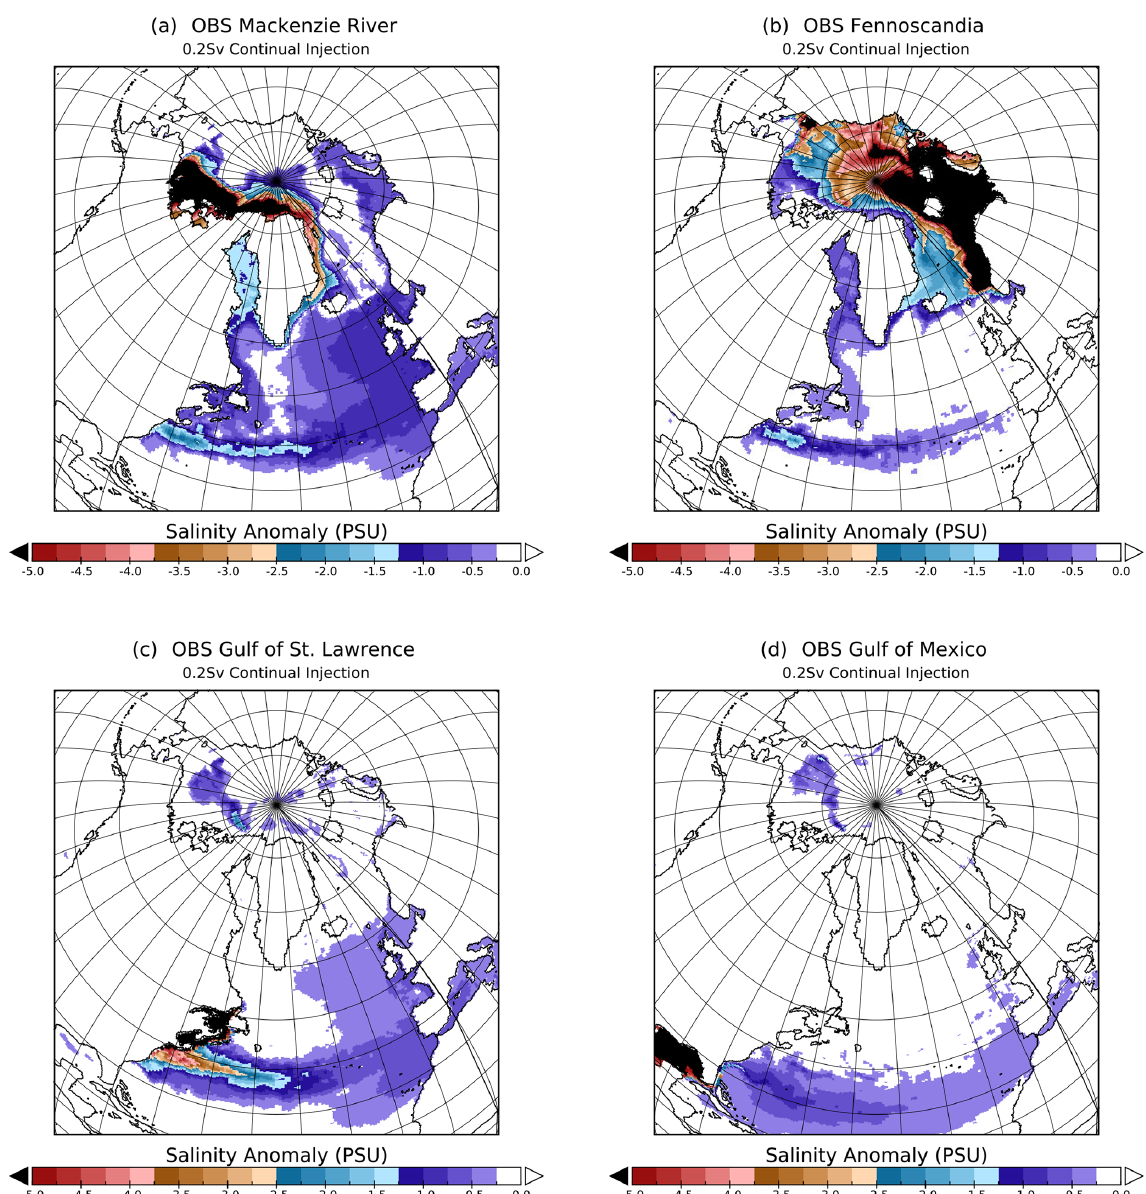
Figure 3. Time-averaged sea surface salinity anomaly from the last 5 years of each of the OBS injection simulations; the CBS MAK experiment is available in Fig. S5 in the